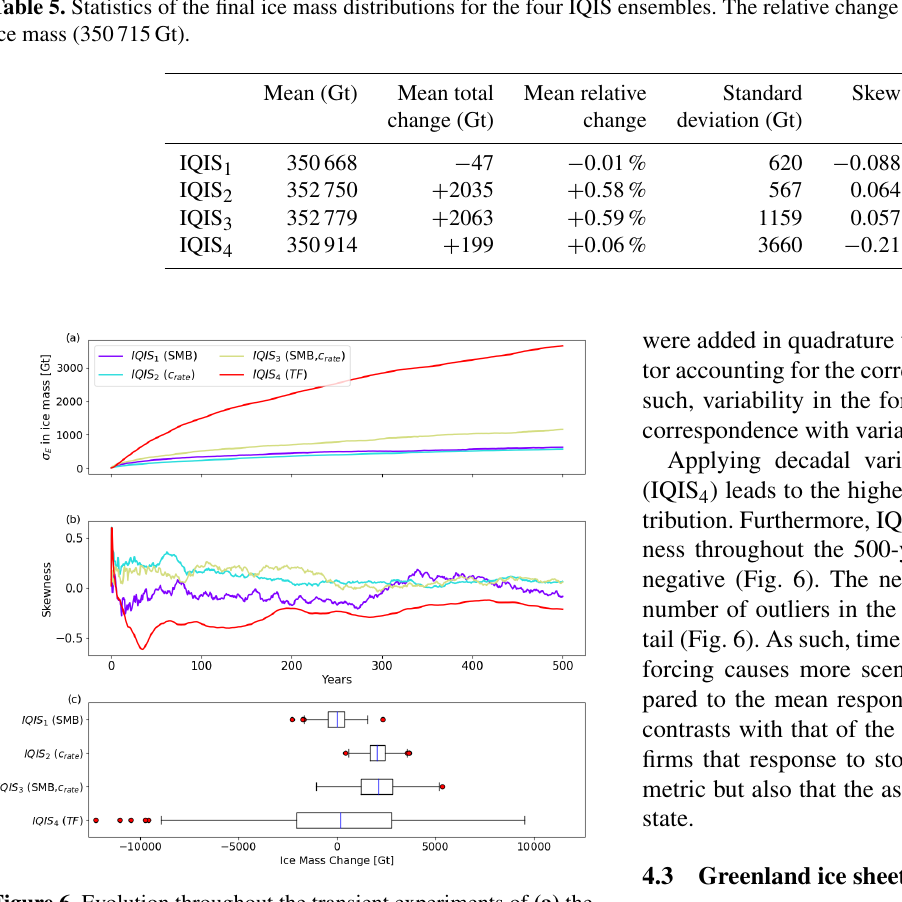
Figure 6. Evolution throughout the transient experiments of (a) the standard deviation and (b) the skewness in total ice mass for the four IQIS ensembles. (c) Boxplots of the final ice mass distributions. The dashed line shows the initial ice mass, from the deterministic steady state. Red dots indicate ice masses beyond 1.5 times the interquar- tile range from the quartile. In labels, variables between brackets denote variables with stochastic variability imposed (Table